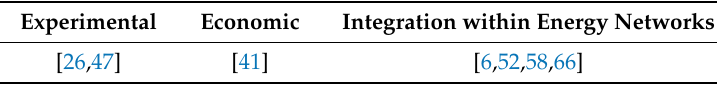
Table 2. Studies that deal with the listed analysis